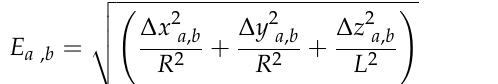
Figure 5. Ellipsoidal flight protection zone.